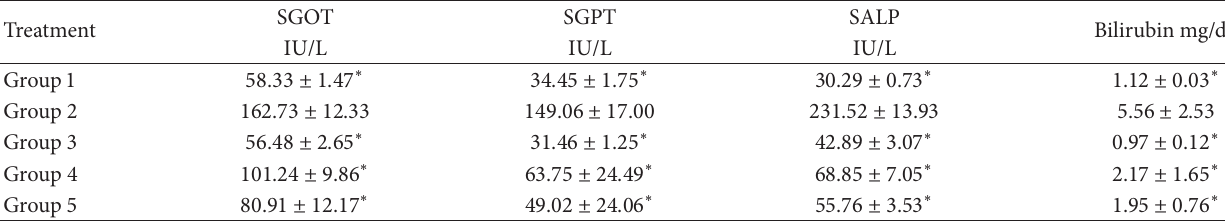
Table 6: The effect of palmatine on serum enzyme and bilirubin levels in mice.